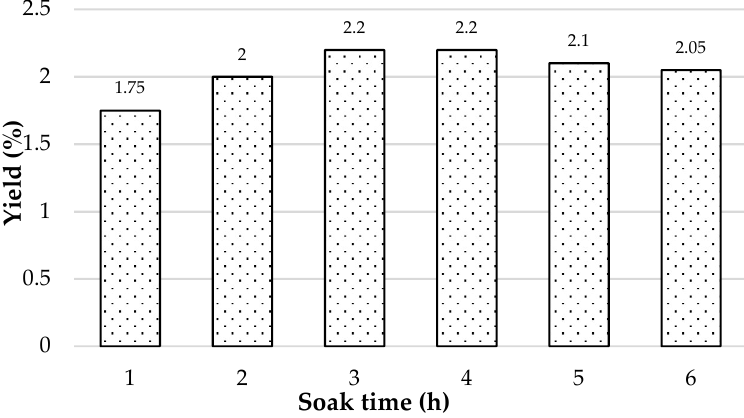
Figure 6. The influence of the concentration of soak time on the yield of essential oil.